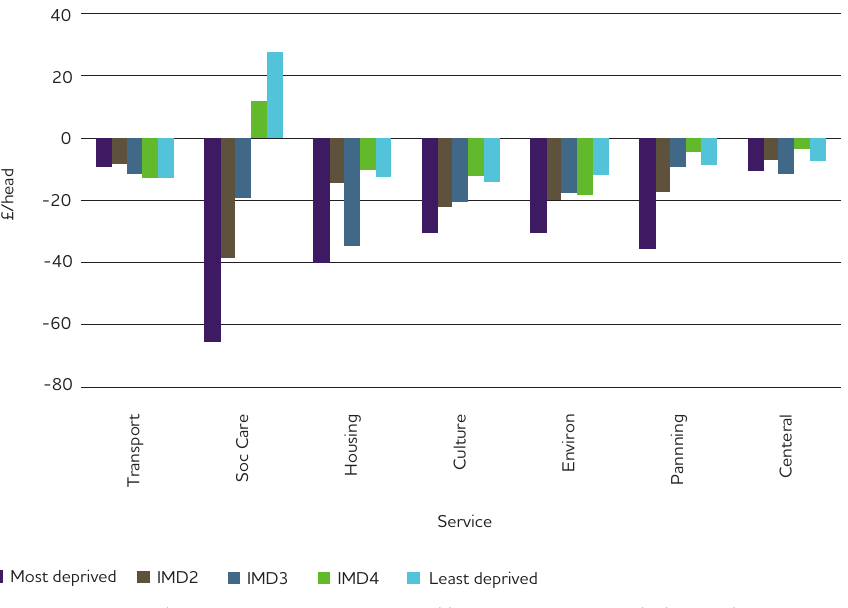
Figure 5: Real Budget Changes by Service for English All Purpose Authorities by Deprivation Band, £/head,